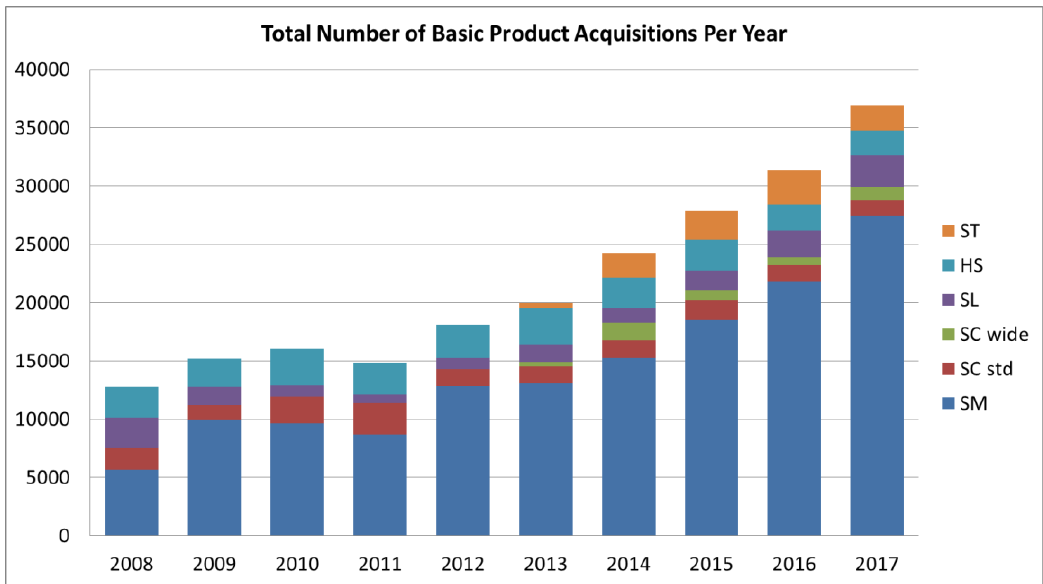
Figure 17. Total number of basic product acquisitions per year.